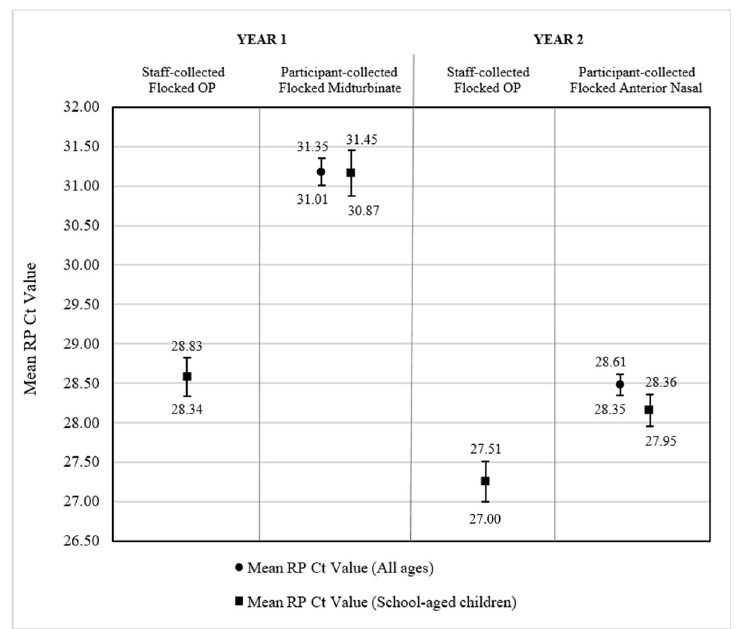
Fig 5. Mean RP Ct values of staff- and participant-collected respiratory specimens. Bars present the 95% confidence intervals for the mean human ribonuclease P (RP) cycle threshold (Ct) values of (from left to right) staff- collected oropharyngeal (OP) specimens from school-aged children in Year 1 using Copan FLOQSwabs ™ flocked swabs, participant-collected midturbinate specimens from participants of all ages in Year 1 using Copan FLOQSwabs ™ flocked midturbinate swabs, participant-collected midturbinate specimens from school-aged children (ages 4–18) in Year 1 using Copan FLOQSwabs ™ flocked midturbinate swabs, staff-collected OP specimens from school-aged children in Year 2 using Copan FLOQSwabs ™ flocked swabs, participant-collected anterior nasal specimens from participants of all ages in Year 2 using Puritan Sterile Foam Tipped Applicators, and participant-collected anterior nasal specimens from school-aged children in Year 2 using Puritan Sterile Foam Tipped